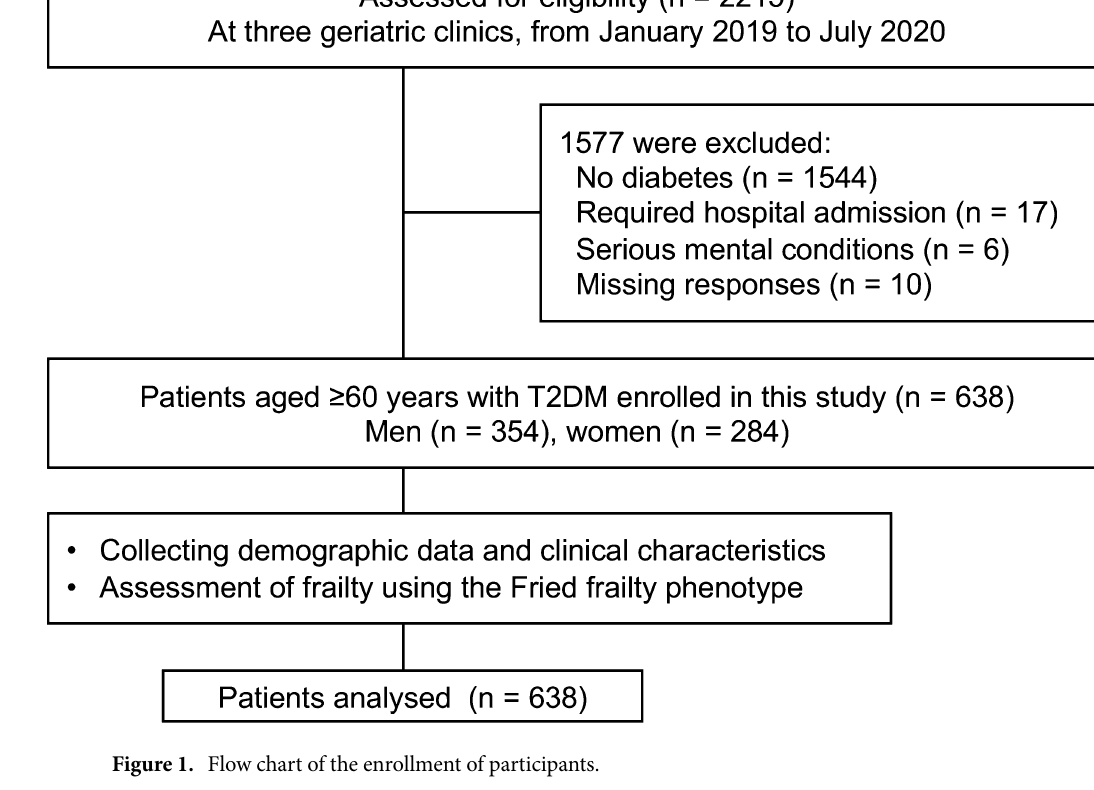
Figure 1. Flow chart of the enrollment of